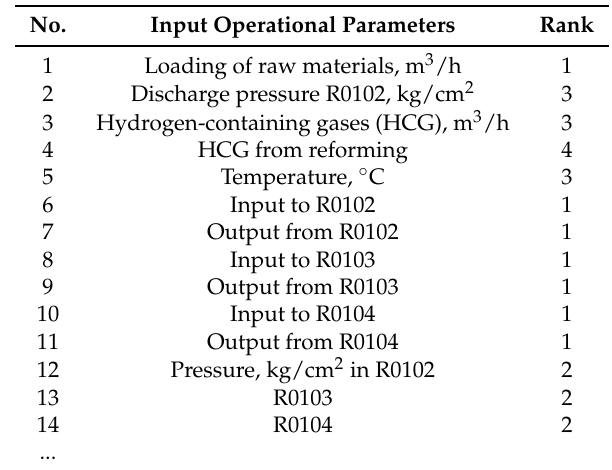
Table 1. List of input and operating parameters of reactor block within catalytic cracking unit as well as results of expert